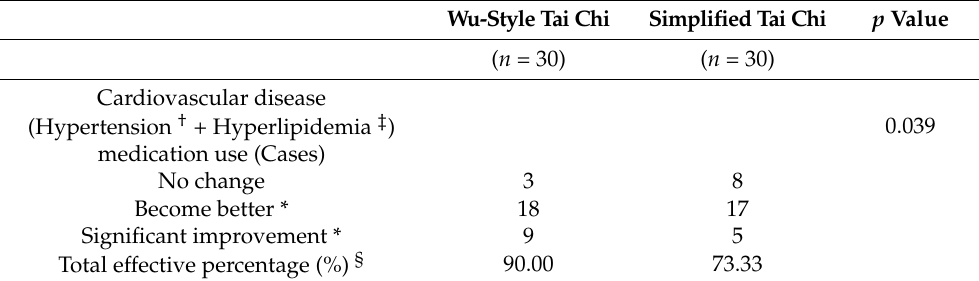
Table 4. Cardiovascular disease clinically meaningful improvement between the Wu-style Tai Chi group and the simplified Tai Chi group during 6 weeks